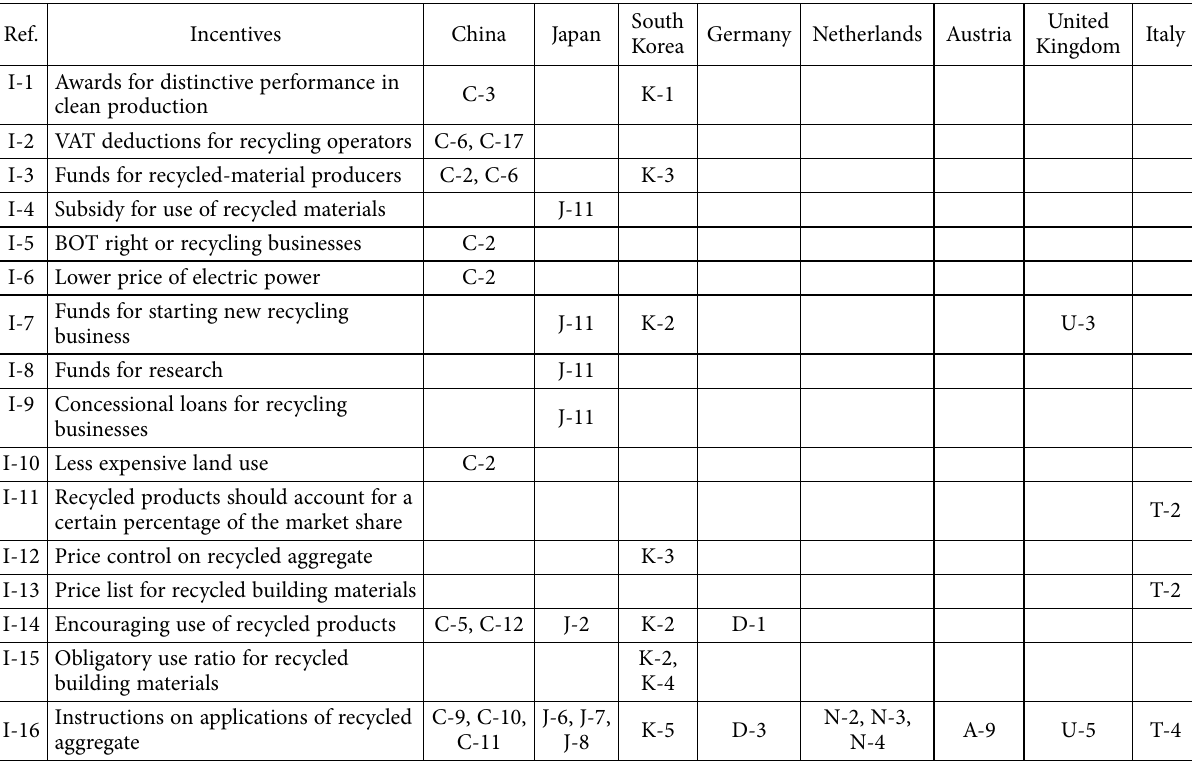
Table 12. Comparison on incentives